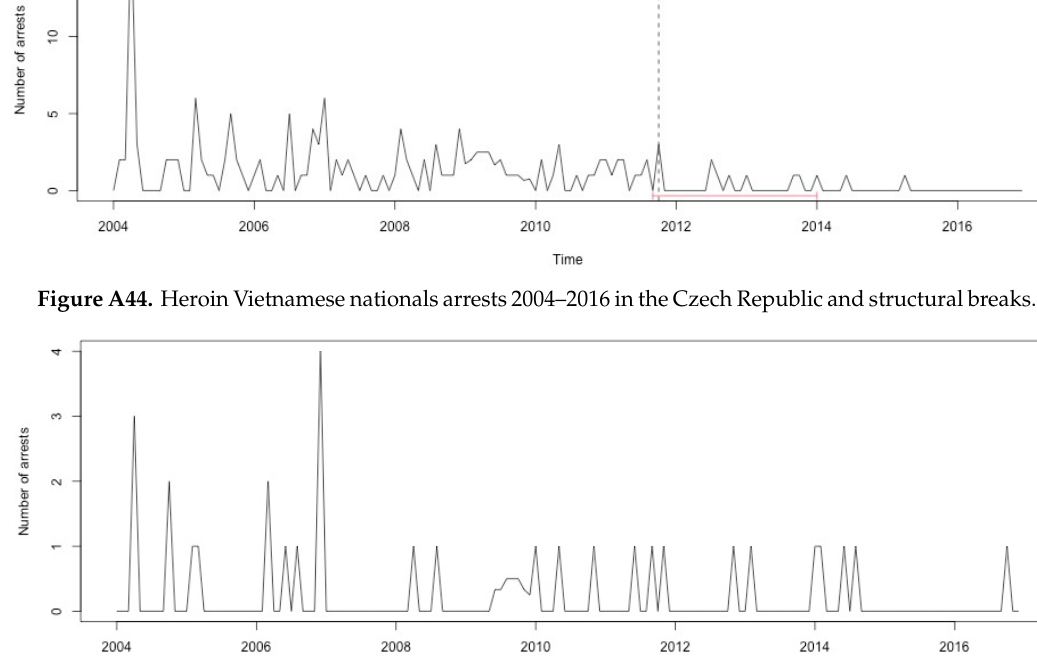
Figure A45. Heroin neighboring countries nationals arrests 2004–2016 in the Czech Republic and structural breaks.